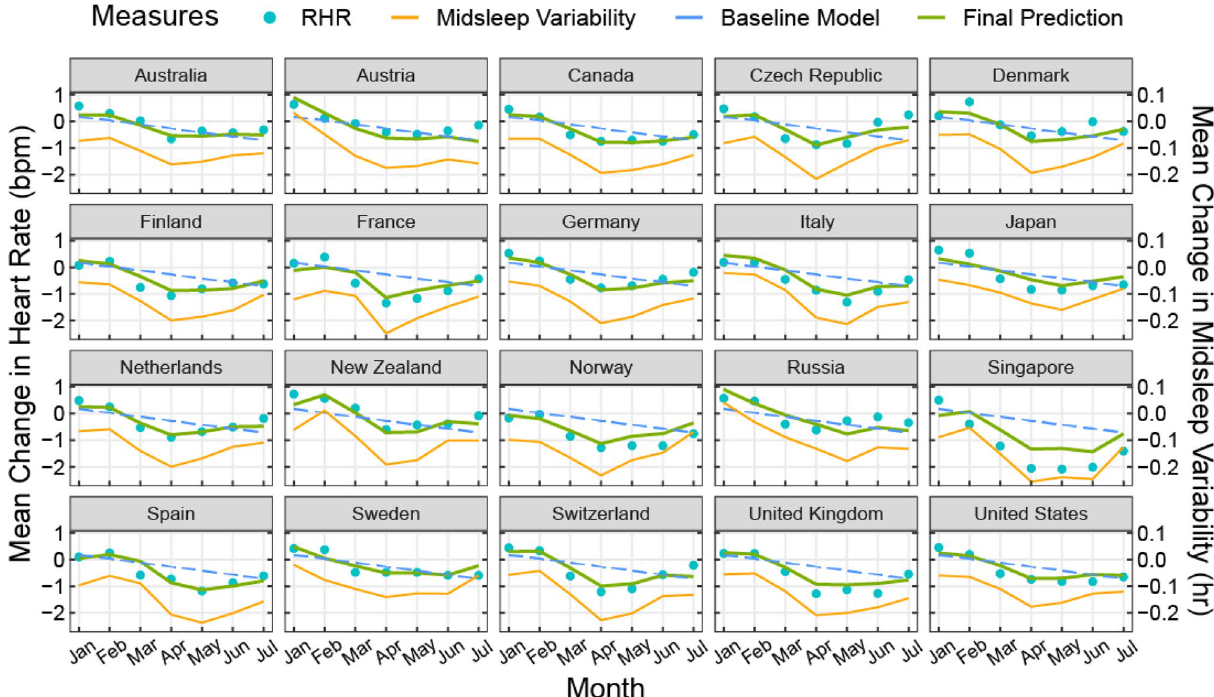
Figure 4. Prediction of changes in resting heart rate by changes in sleep patterns. Plots showing final fitted models (green curves) across 20 countries predicting changes in resting heart rate (RHR) (2020–2019) using changes in midsleep time, changes in midsleep variability, and sleep duration in 2020 as time-varying predictors in the same model. Observed mean differences between 2020 and 2019 (blue dots) and predictions without sleep variability in the model (blue dashed line) are also shown for comparison. Sleep variability was found to be the strongest predictor of resting heart rate and is shown here in orange solid line for visualization